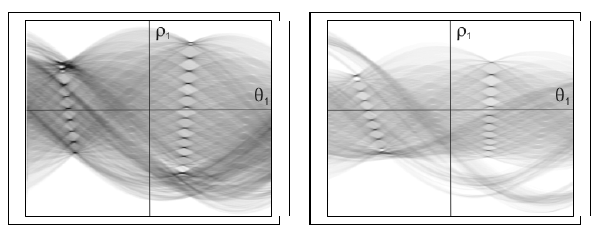
Figure 3. Hough transform of the edge